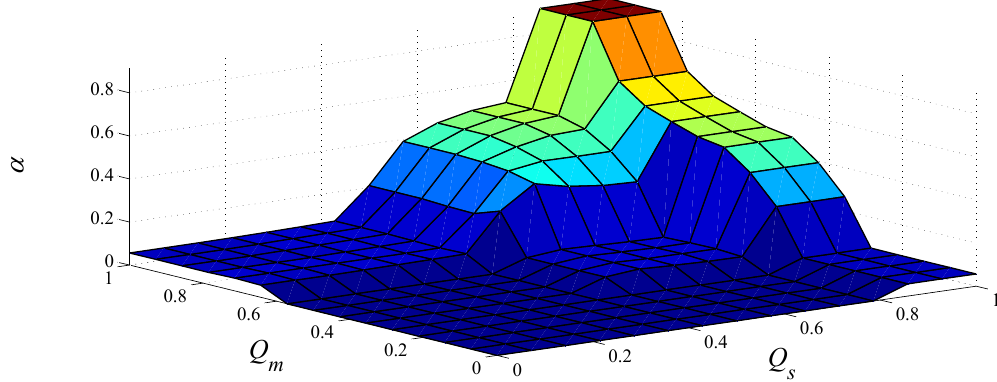
Figure 10. Three-dimensional plot for rule-based